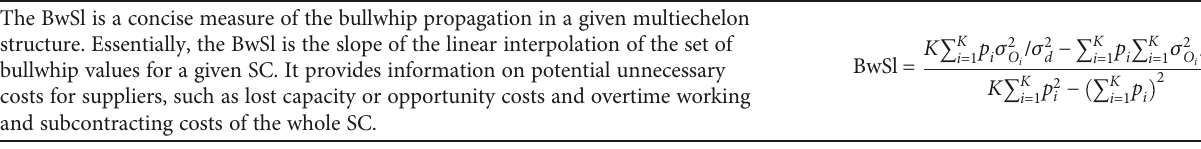
Table 5: Performance metrics.